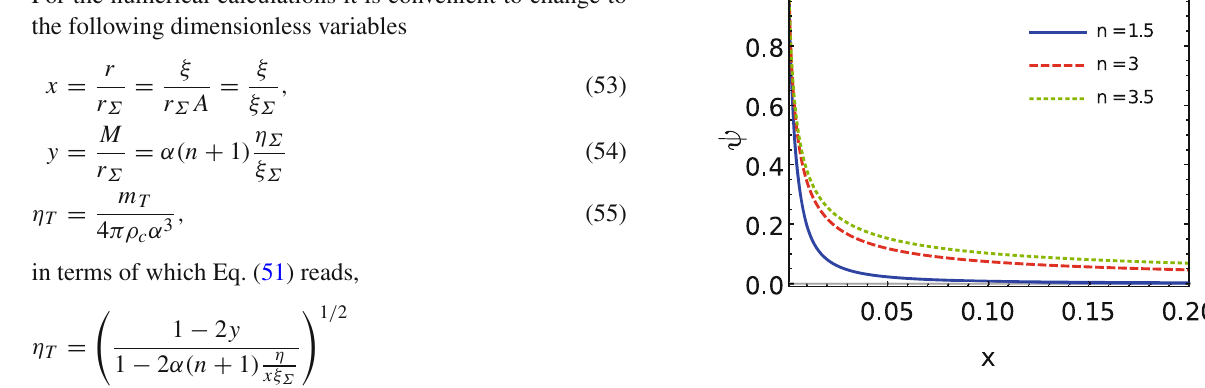
Fig. 3 ψ as function of x for α = 0 . 1 and different values of n